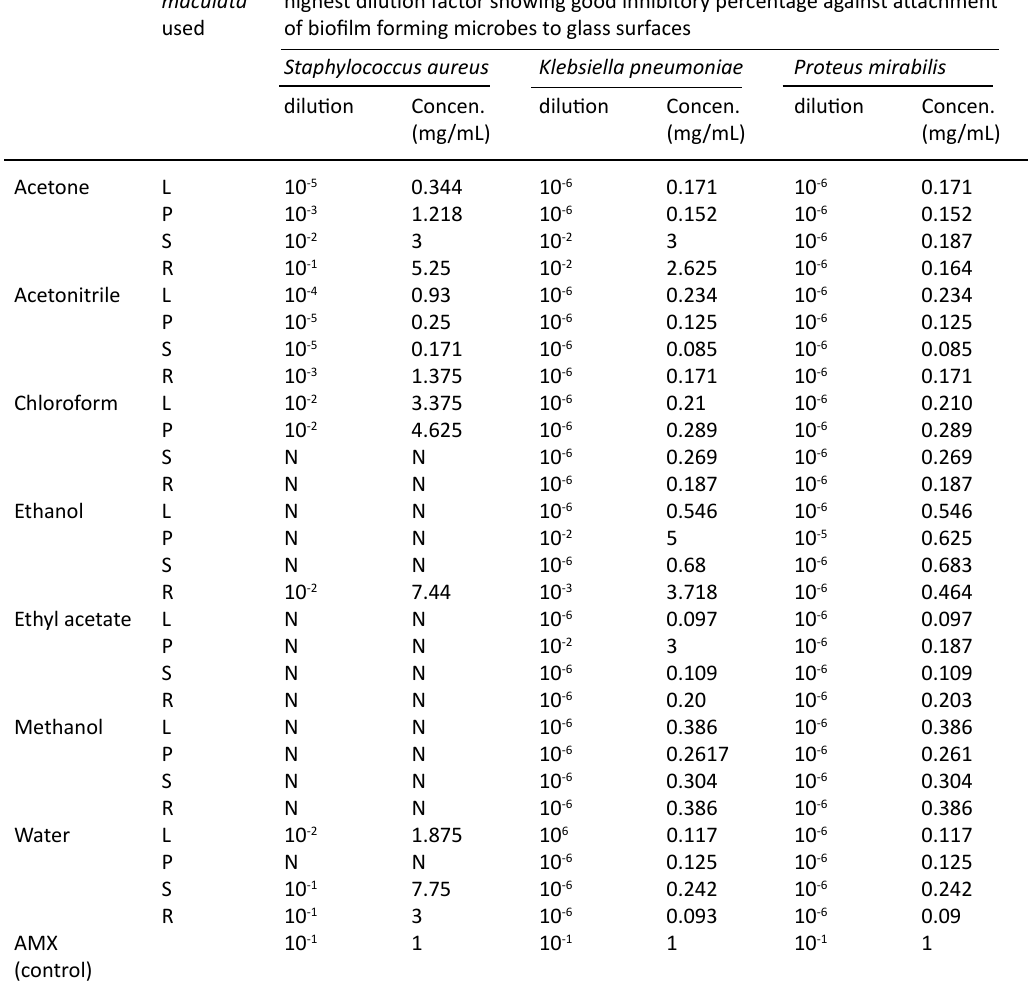
table 9. Minimum Biofilm Inhibitory Concentration (MBIC) of Pleione maculata based on highest dilution to show inhibition against tested clinical isolates Solvents Parts of